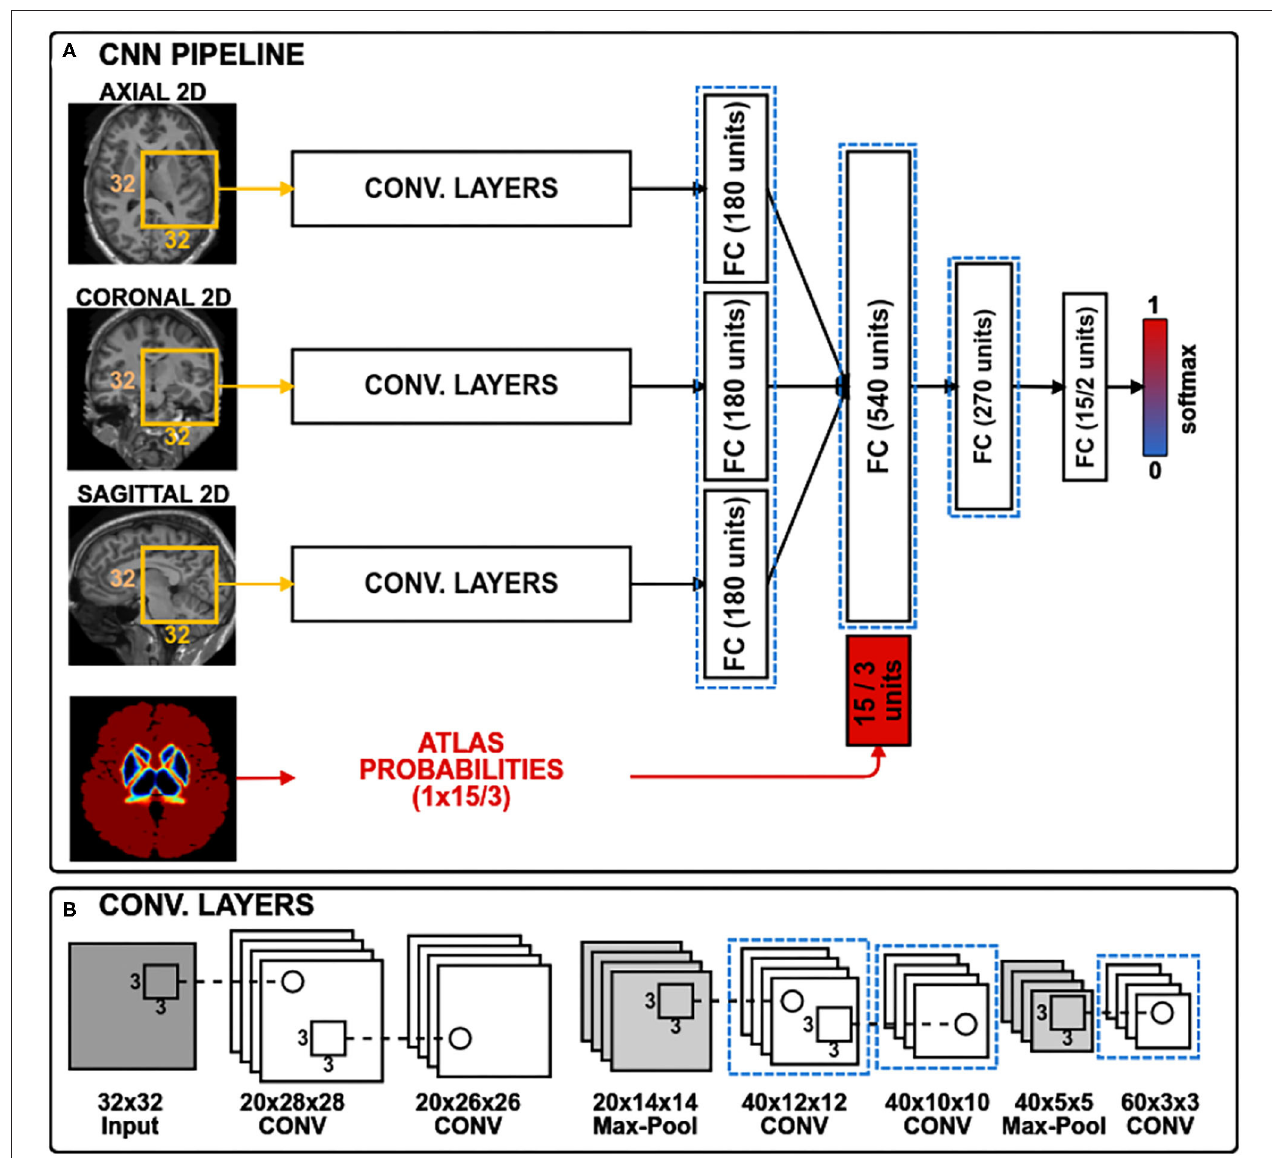
FIGURE 1 | The CNN architecture has three convolutional branches and a branch for spatial priors. 2D patches of size 32 × 32 pixels are extracted from three orthogonal views of a 3D volume. For sub-cortical structure segmentation, the spatial prior branch accepts a vector of size 15 with atlas probabilities for each of the 14 structures plus the background, whereas for the WMH lesion segmentation the vector size is three corresponding to white matter, gray matter and cerebrospinal fluid. Histogram loss is computed from the activation maps of the layers, highlighted with dashed blue rectangles. (A) CNN pipeline; (B) Convolutional